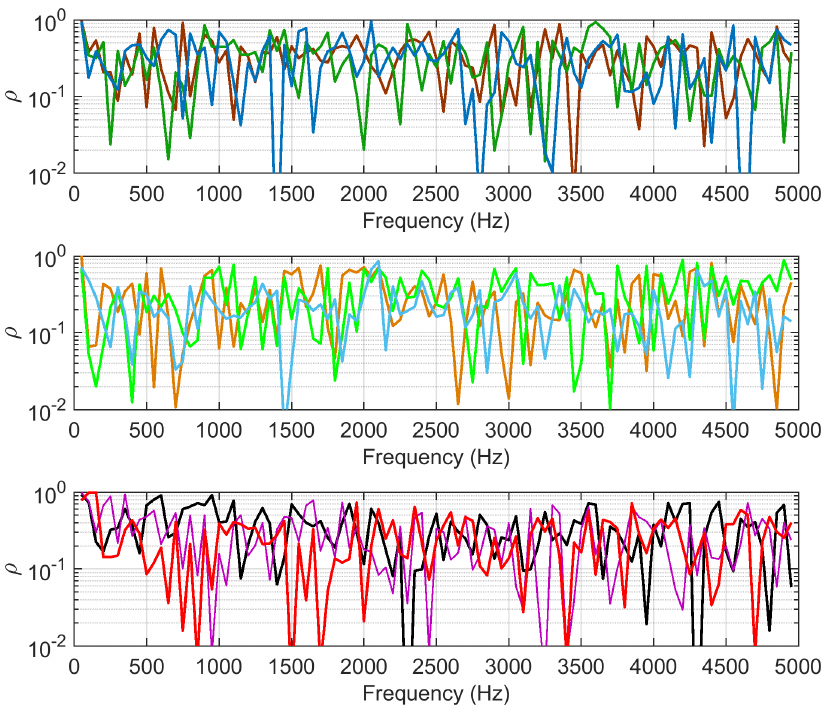
Figure 13. Correlation between groups of spectra: cross-correlation in traction (top) and braking (middle) conditions (CH vs. D (brown), CH vs. F (blue), and D vs. F (green)); cross-correlation between traction and braking conditions for the same rolling stock (CH (black), D (violet), F